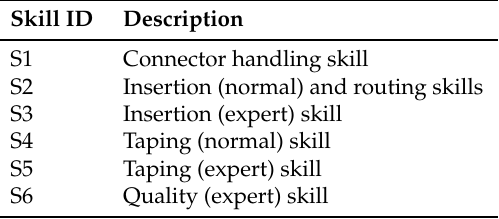
Table 4. Description of skills that should be used in the studied production process.